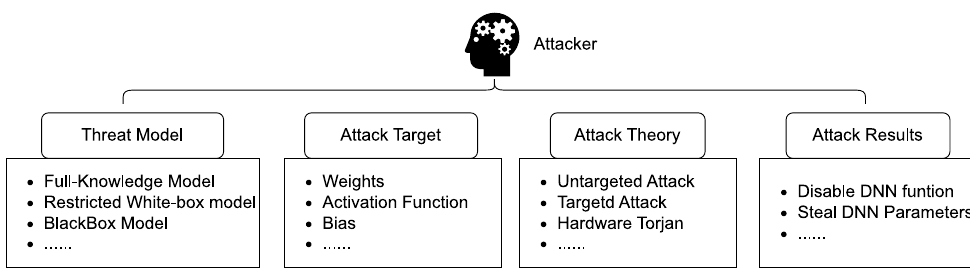
Figure 7. Some factors that attacker needs to